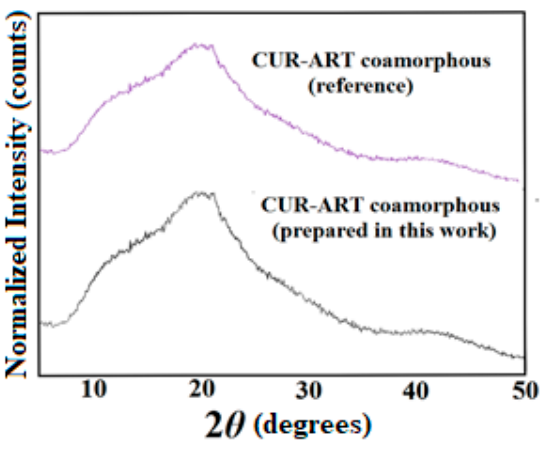
Figure 1. Bulk phase of CUR-ART powder X-ray diffraction (PXRD) pattern matches with the reported reference compound by PXRD [29].